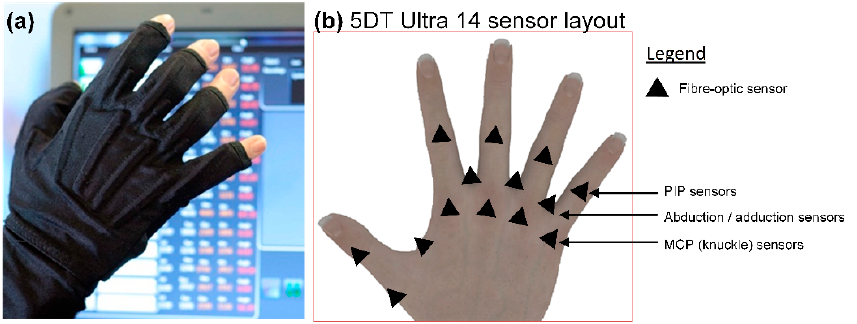
Figure 1. ( a ) 5DT data glove with bespoke controlling software in image background. ( b ) Diagram showing sensor positioning for the 5DT data glove. showing sensor positioning for the 5DT data